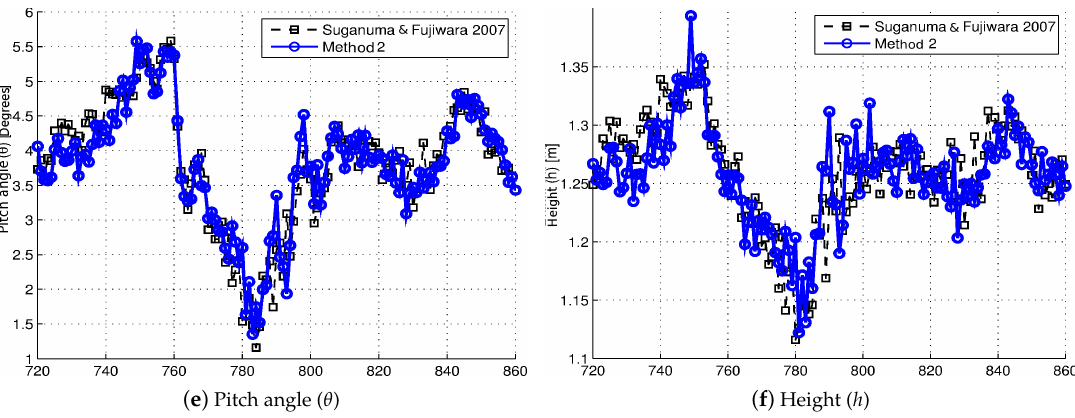
Figure 14. Self-calibration results of the extrinsic parameters ( ρ , θ , h ) in a real traffic environment (Example